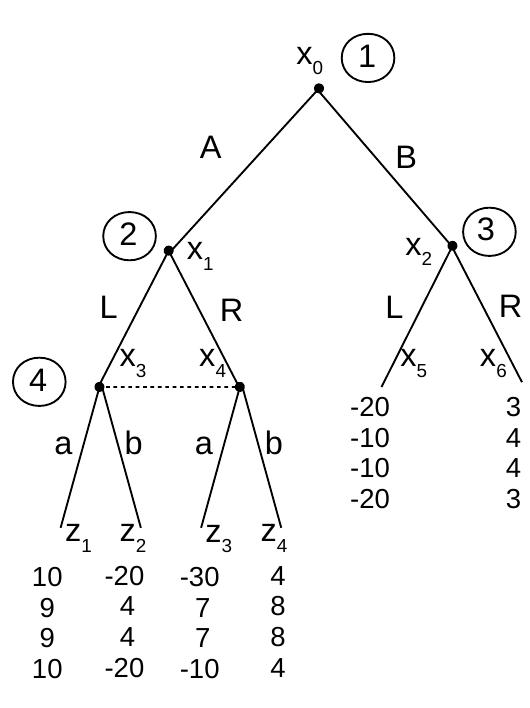
Figure 4. Incredible threat in this game poses no